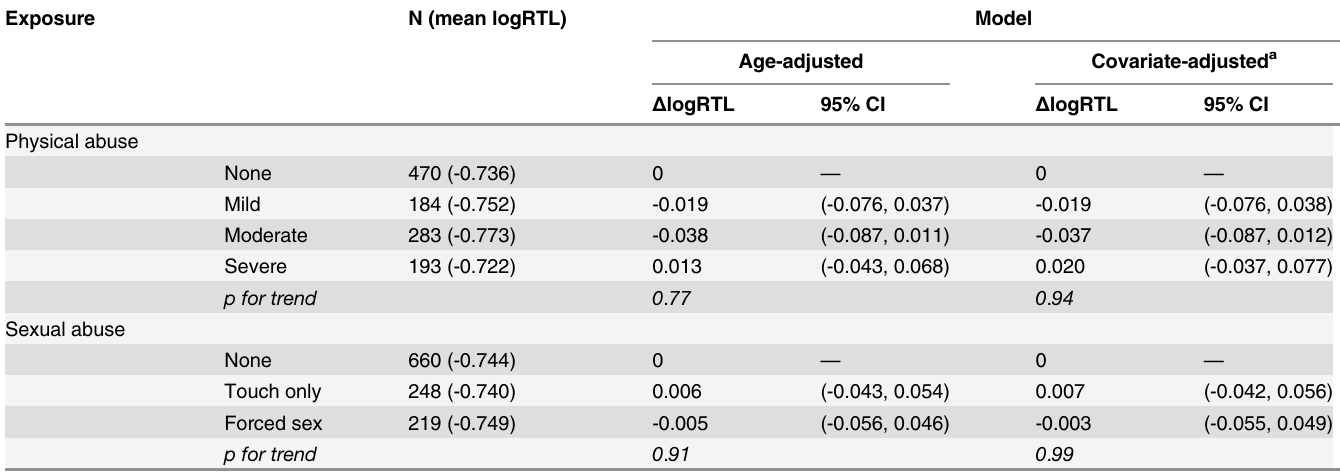
Table 3. Estimated difference in relative telomere length (RTL) by severity of childhood physical and sexual abuse.